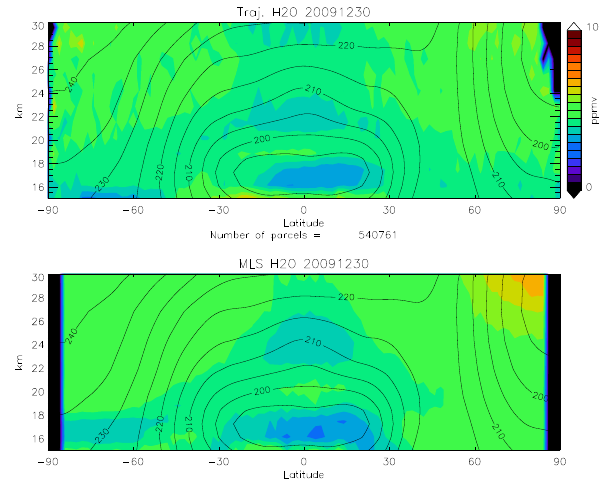
Fig. 4. Mean age averaged over a 2009 at 20km with measurements based on CO 2 and SF 6 from Waugh and Hall (2002). Solid line, kinematic integration; dashed line, diabatic integration.